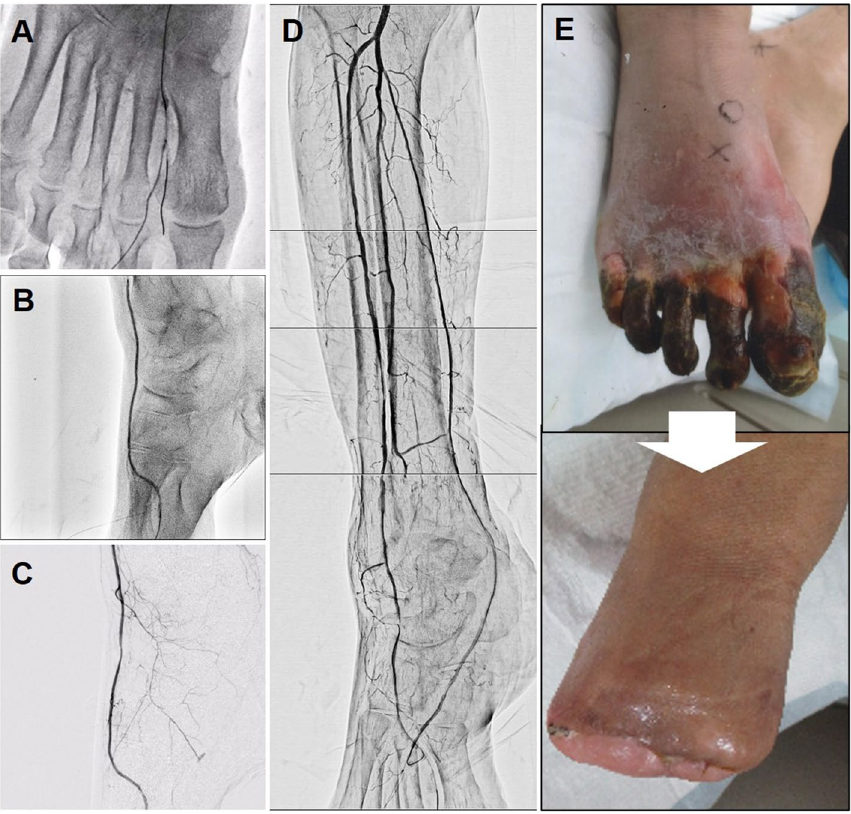
Fig. 4 a Antegrade guidewire advancement to the first digital artery. b Balloon dilation to hemostat the puncture site of the first dorsal metatarsal artery. c Confirmation of complete hemostasis. d Final angiography showing good vascular patency and favorable blood flow. e (Upper panel) Severe gangrene in all the digits of the right foot before endovascular treatment. (Lower panel) Favorable wound healing after